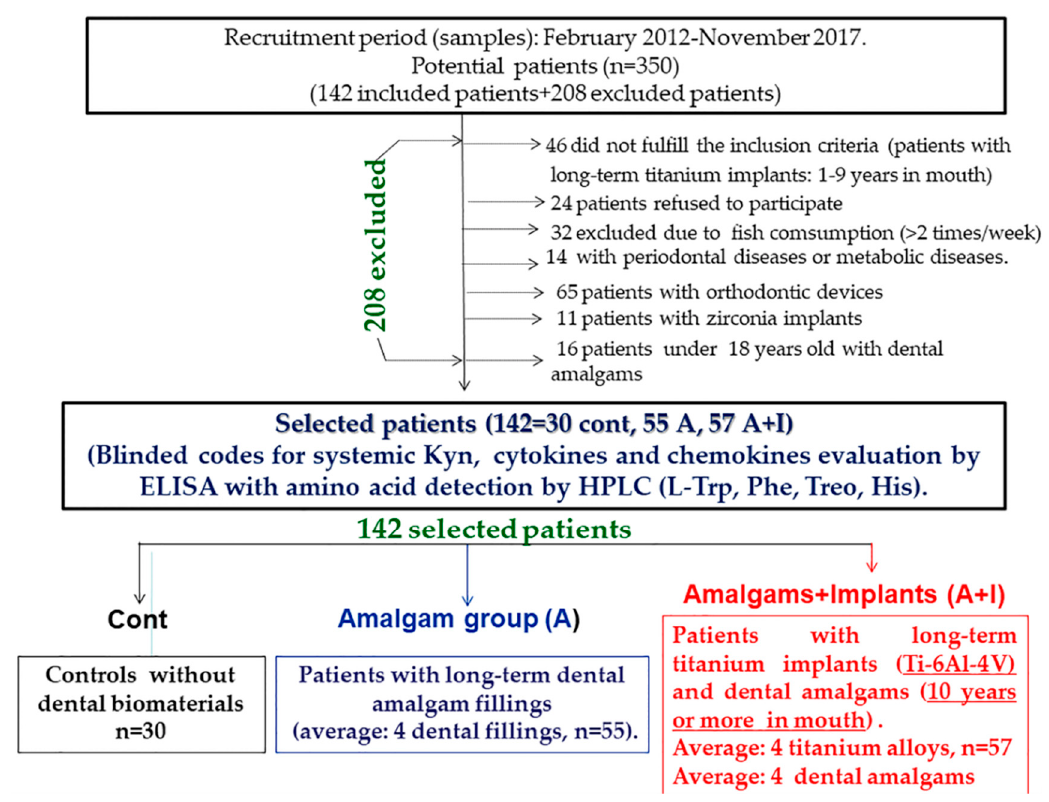
Figure 1. Study groups.